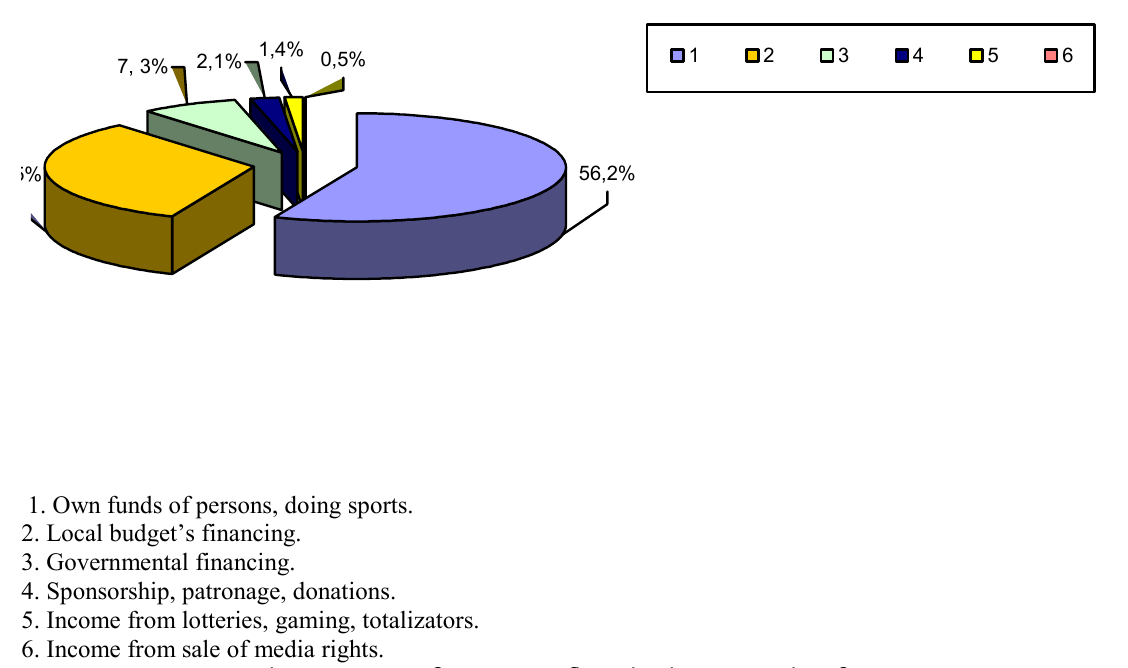
Fig.1. Structure of mass sports financing in 27 countries of